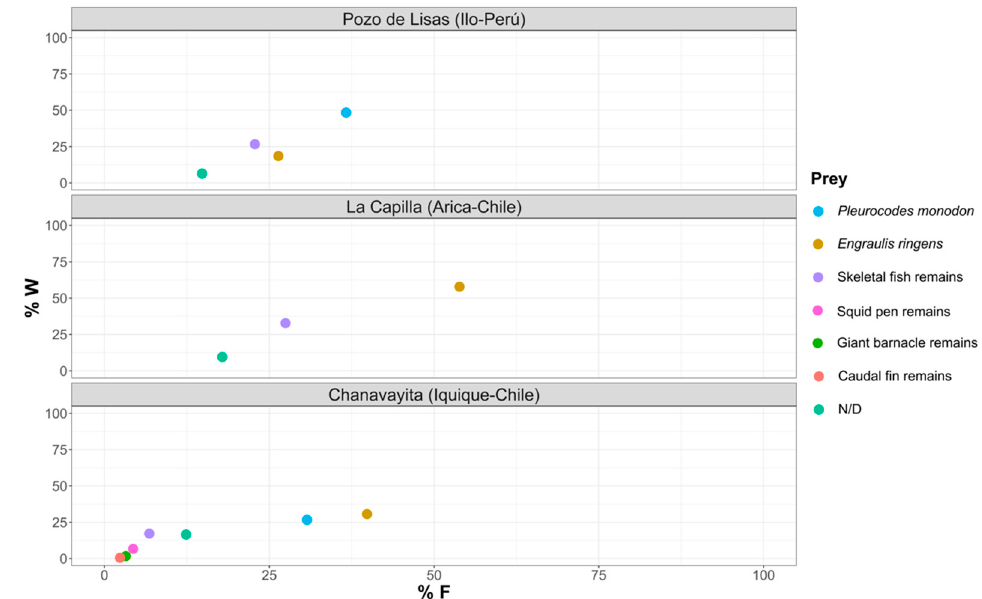
Figure 9. Feeding strategy for each of the study areas, according to Costello’s method [39]. Study of trophic relationships (%W represents the percentage by weight of the gravimetric method).